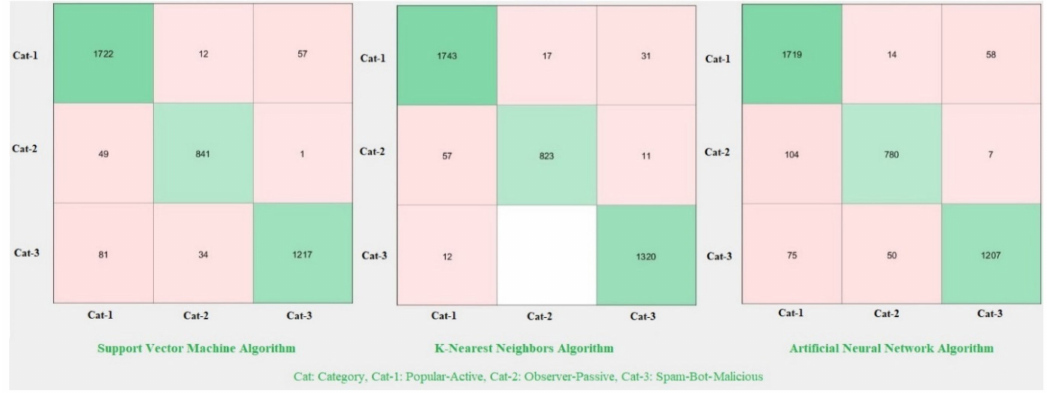
Figure 2. Confusion matrix results.